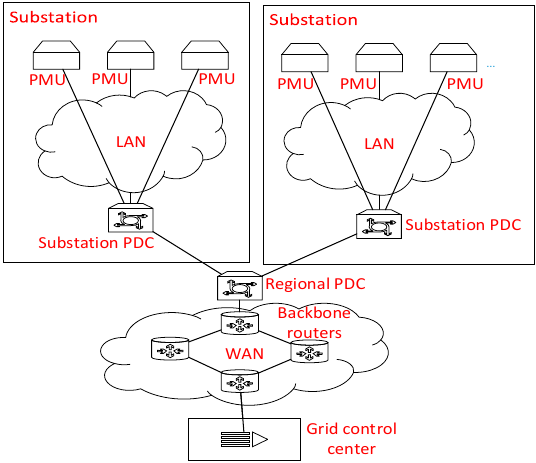
Figure 1. Synchrophasor communication between PMUs and PDCs.